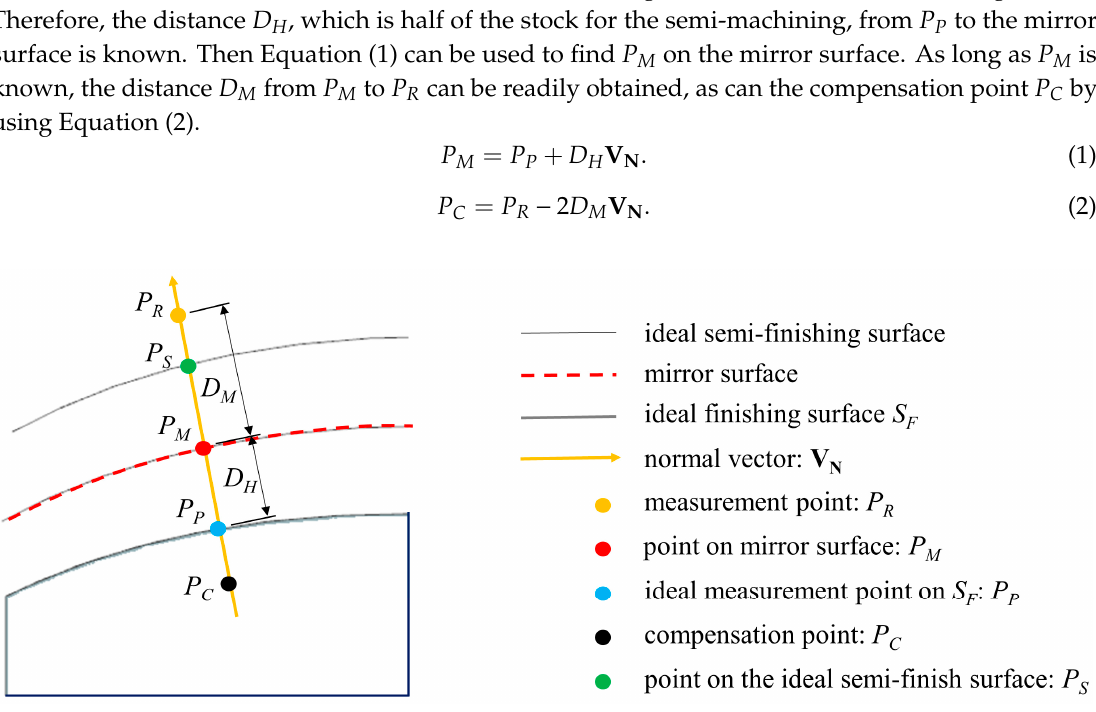
Figure 7. The locations of the points used for the mirror compensation method.